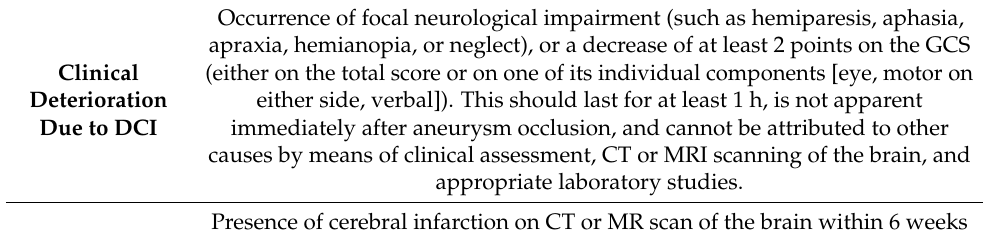
Table 1. Consensus definition of clinical deterioration and cerebral infarction due to